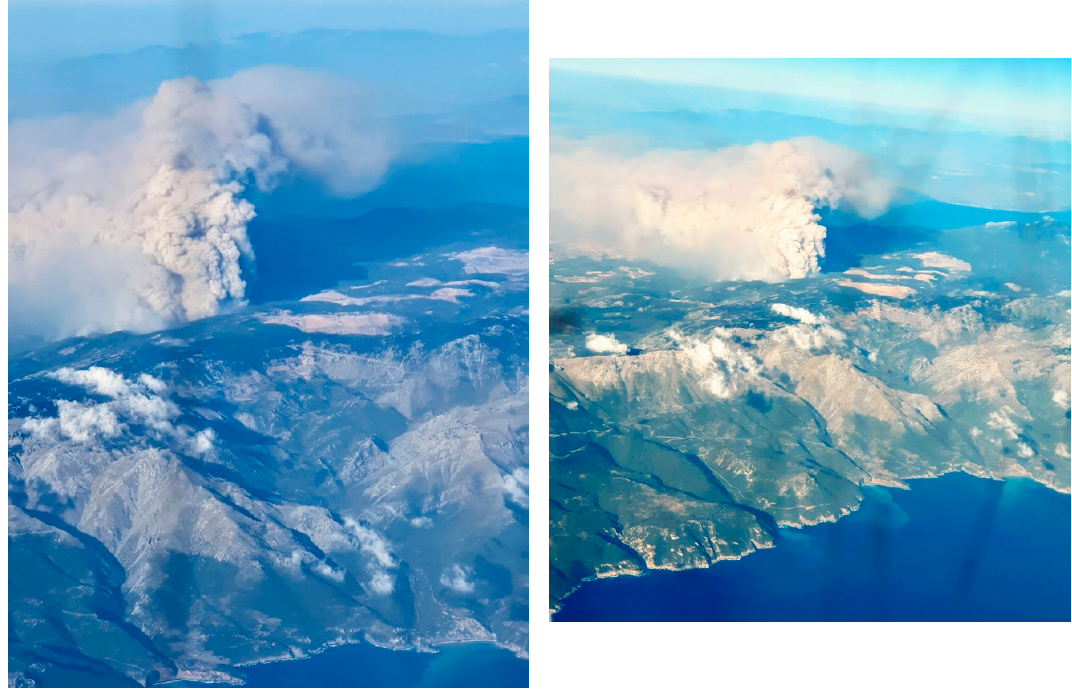
Figure 4. Aspects of the convective plume of the Kontodespoti wildfire at 05:43 UTC on 13 August 2019, as seen from onboard a commercial flight. (Photographs courtesy of Fotis Fillipopoulos, Twitter: @F_Fillipopoulos).